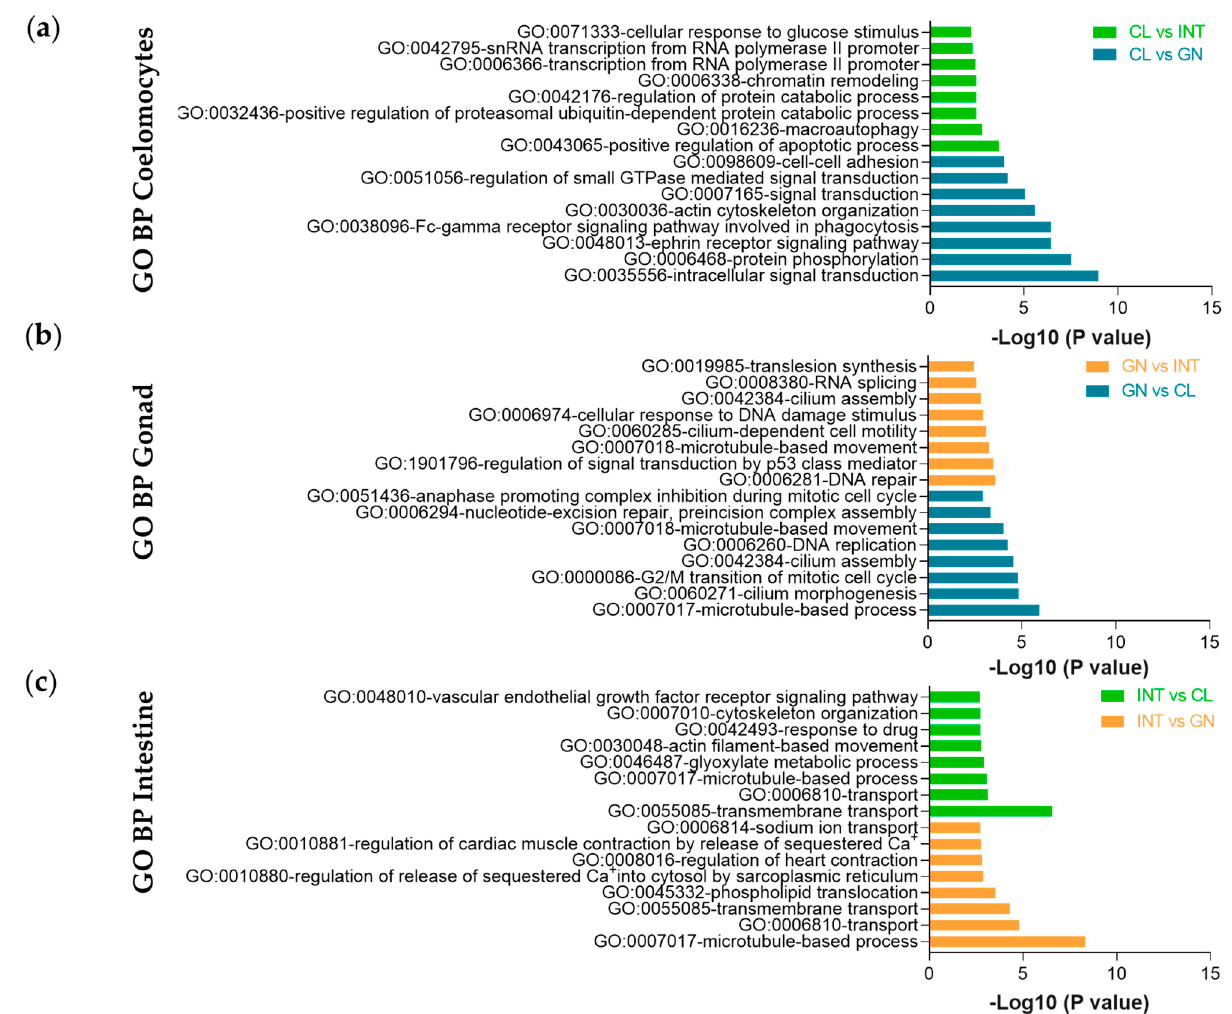
Figure 8. The Top-16 Gene Ontology biological process (BP) enrichment of up-regulated transcripts from L. albus tissues. ( a ) In coelomocytes compared to intestine (CL vs. INT), the most enriched term was positive regulation of apoptotic process, and compared to the gonad (CL vs. GN) was intracellular signal transduction; ( b ) in the gonad compared to intestine (GN vs. INT), the most enriched term was DNA repair, and compared to coelomocytes (GN vs. CL) was microtubule-based process; ( c ) in intestine compared to coelomocytes (INT vs. CL) the most enriched term was transmembrane transport, and compared to the gonad (INT vs. GN) was microtubule-based process.